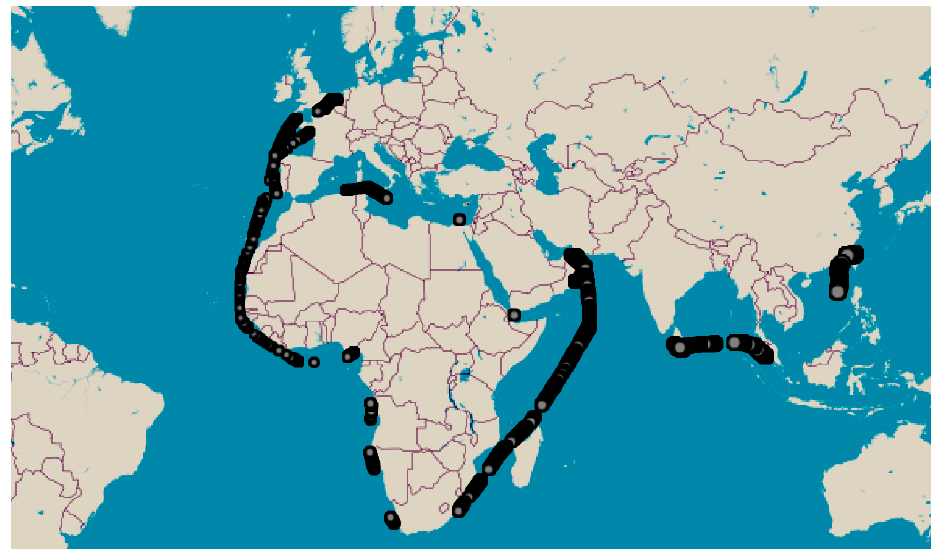
Figure 5. Graphical presentation of executed routes.